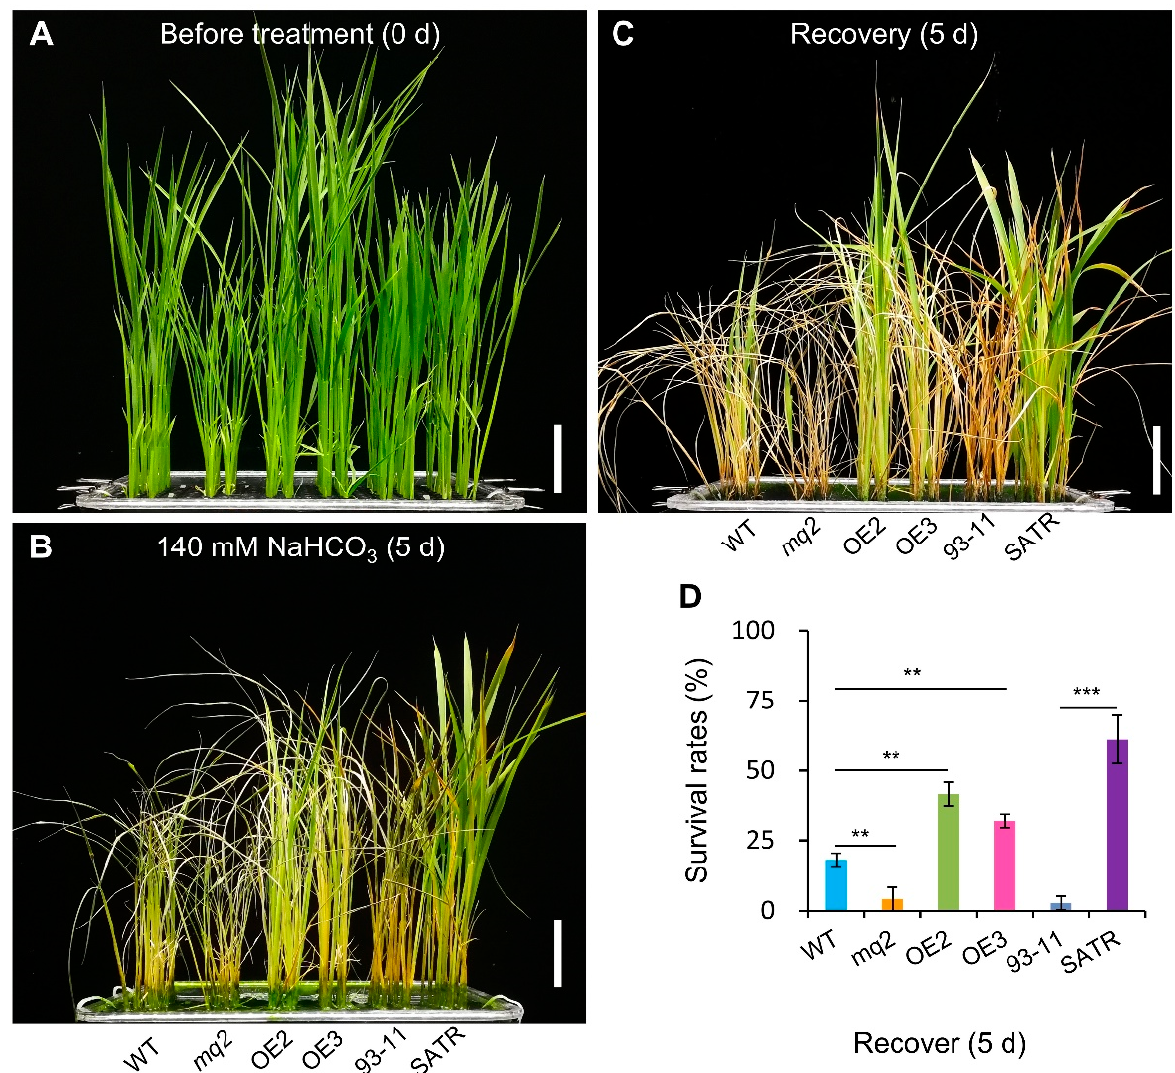
Figure 7. Saline–alkali tolerance analysis of OsCSLD4 function-disrupted mutant and overexpression lines. ( A – C ) Performance of OsCSLD4 function-disrupted mutant ( mq2 ), OsCSLD4 -overexpression lines (OE2 and OE3) compared with their wild-type plants (Kitaake, WT), as well as 93-11 and SATR seedlings before SSAS treatment ( A ), on the 5th day after SSAS treatment ( B ), and after 5 days of recovery without SSAS treatment ( C ), respectively. ( D ) Survival rate of WT, mq2 , OE2, OE3, 93-11 and SATR seedlings after 5 days of recovery. Bar = 5 cm ( A – C ). Data is given as mean ± SD, which was obtained from three independent biological replicates, and each sample contained 24